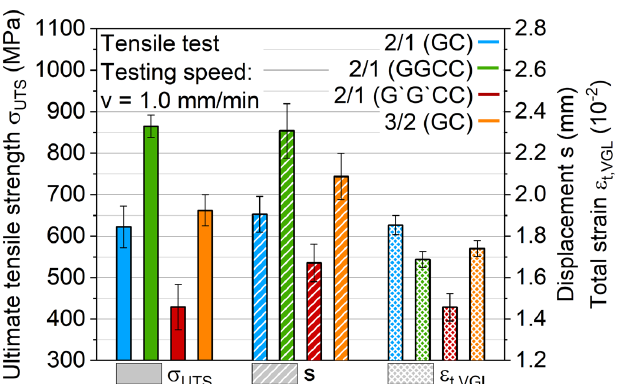
Figure 11. Arithmetic tensile strength and strain values of hybrid laminates with aluminium alloy AA6082-T4 and a graded structure of glass and carbon fibre-reinforced PA6 for different layer structures and metal volume contents.